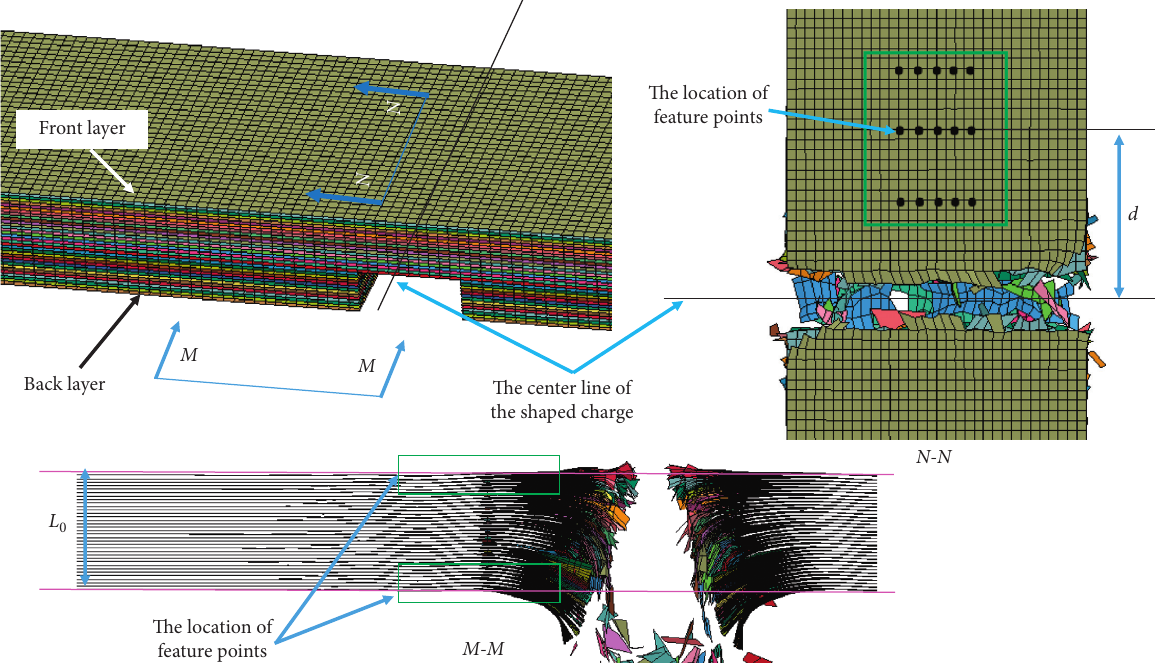
Figure 4: Evaluation of the delamination of the